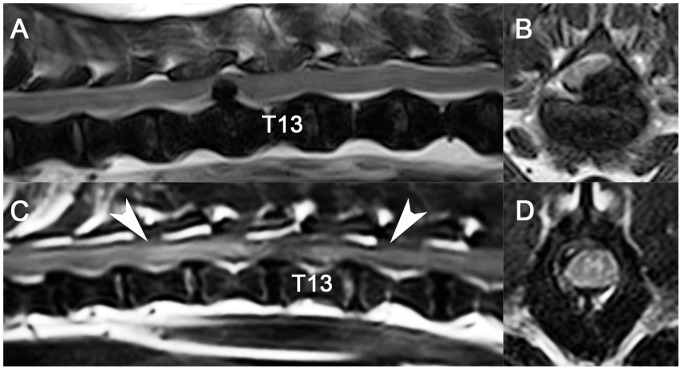
T2-weighted magnetic resonance images in dogs with spinal cord injuries from intervertebral disk herniation.In 1 dog (A, B) that was non-ambulatory with intact pelvic limb movement and sensation, there was focal ventrolateral spinal cord compression at the T12-T13 vertebral articulation without spinal cord signal change. A second dog (C, D) with paraplegia and absent pelvic limb deep nociception had compression at the T12-T13 vertebral articulation. There was extensive spinal cord T2-weighted hyperintensity (white arrows) visible on the sagittal image (C), suggestive of processes seen in contusion injuries such as edema, necrosis, hemorrhage, or cellular infiltrates. The transverse image (D, level of T13 vertebral body) indicated that T2-weighted hyperintensity was predominantly localized to the gray matter.